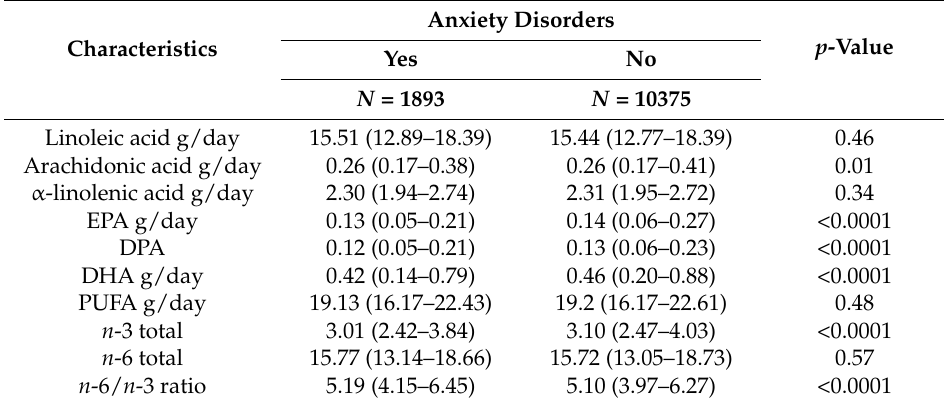
Table 2. Median and Interquartile range of intake of fish in terms of n -3, n -6, n -6/ n -3 ratio, monounsaturated and polyunsaturated fatty acids, according to the presence or absence of anxiety. ELSA-Brazil,